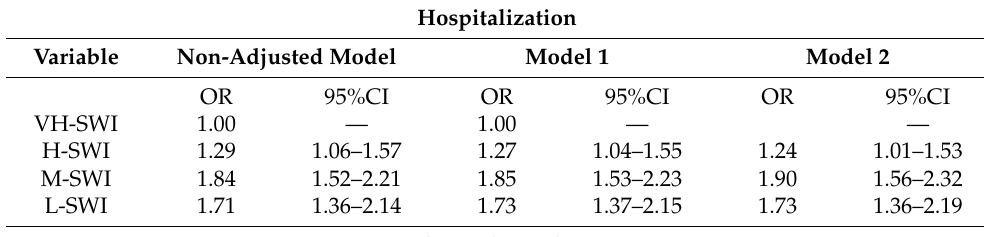
Table 3. Association of the Social Welfare Index with COVID-19 clinical